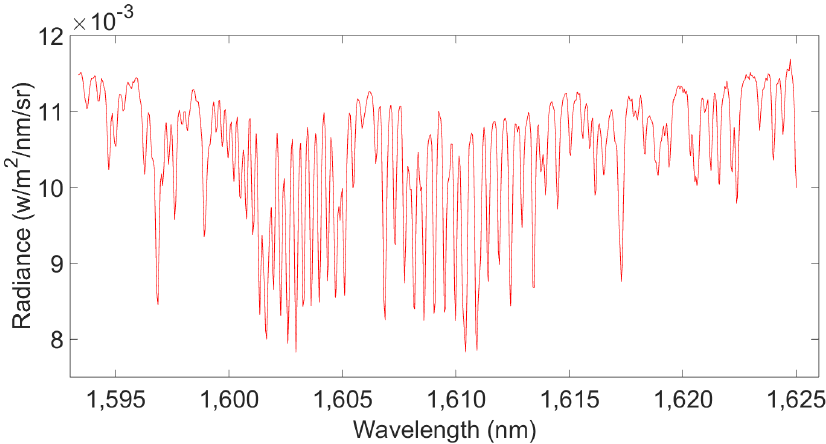
Figure 2. Band 2’s flight test observational L1B data: spectral radiance in 1610 nm.